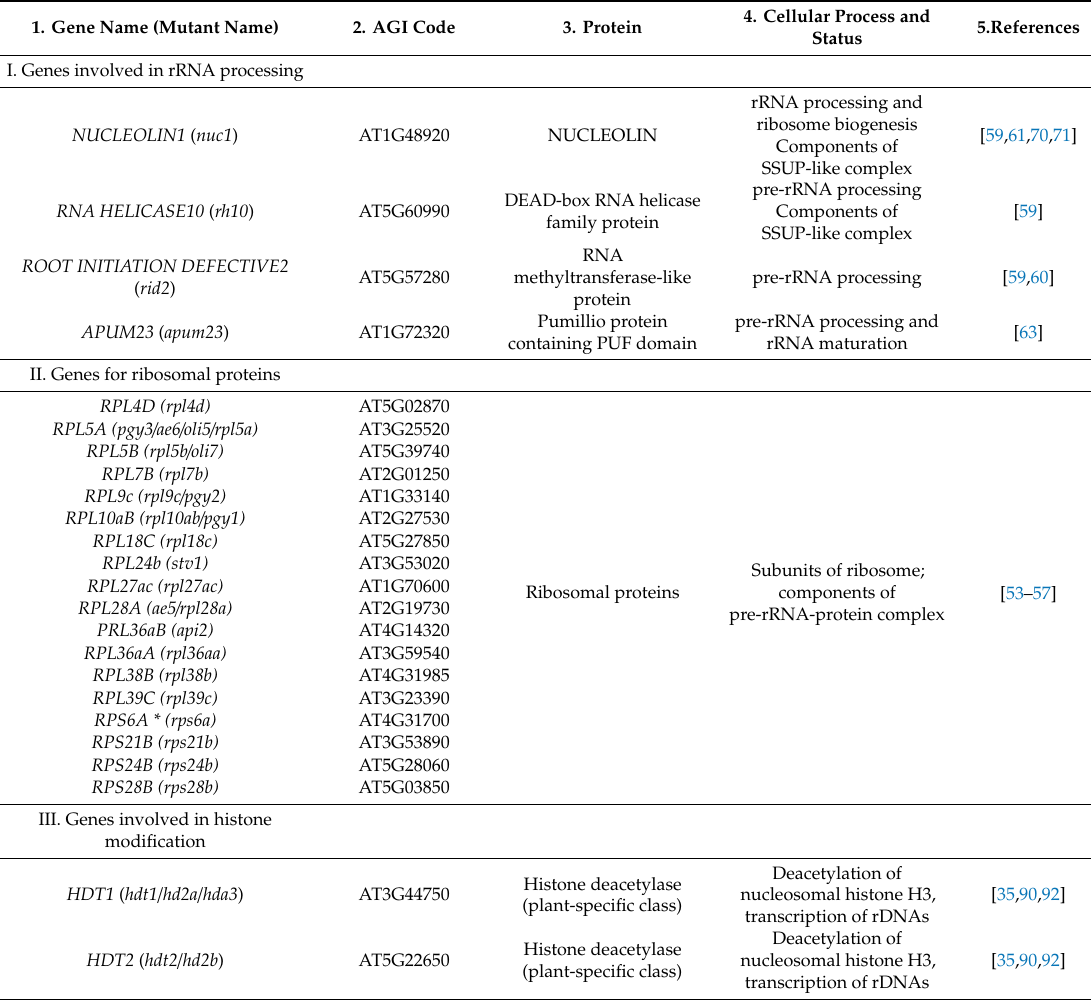
Table 1. Gene mutations that act as modifiers to enhance leaf adaxial–abaxial abnormalities in as2 and as1